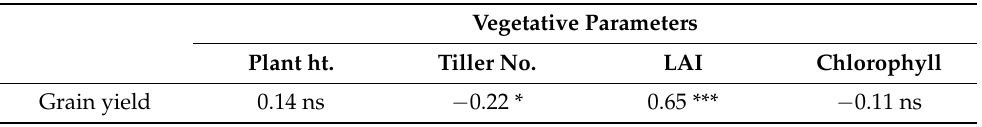
Table 7. Correlations of the plant height, number of tillers, leaf area index, and chlorophyll content with the grain